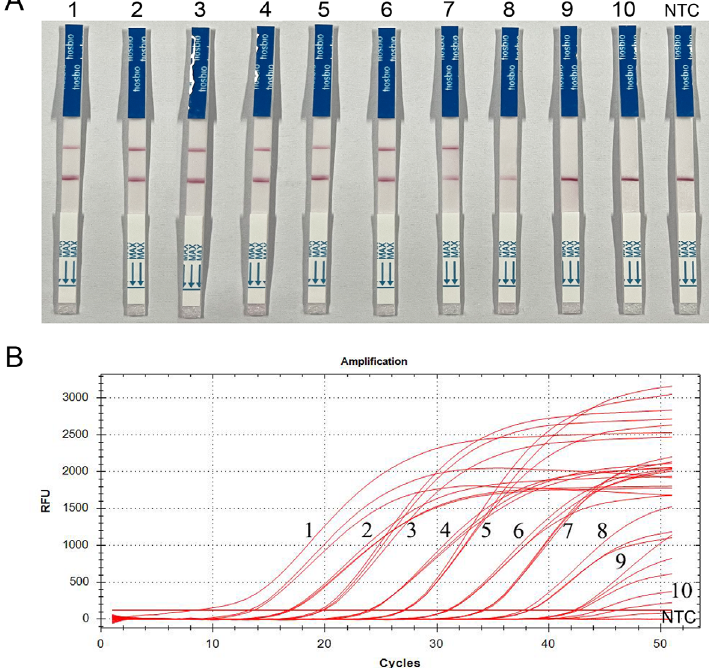
Figure 6. Sensitivity of T. gondii detection by RAA-Cas13a-LFD and qPCR assay. (A) Visual inspection of RAA-Cas13a-LFD. (B) Curves for qPCR. Strip and curves: 1 – 10: plasmid copy number diluted to 1 ng/ l L – 1 (cid:1) 10 (cid:3) 9 ng/ l L, respectively; NTC: negative control (ddH 2